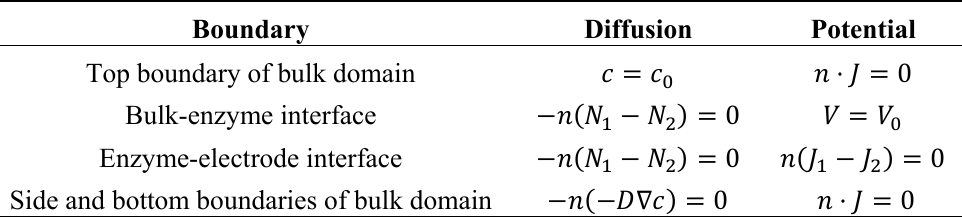
Table 1. Boundary conditions for simulation models.